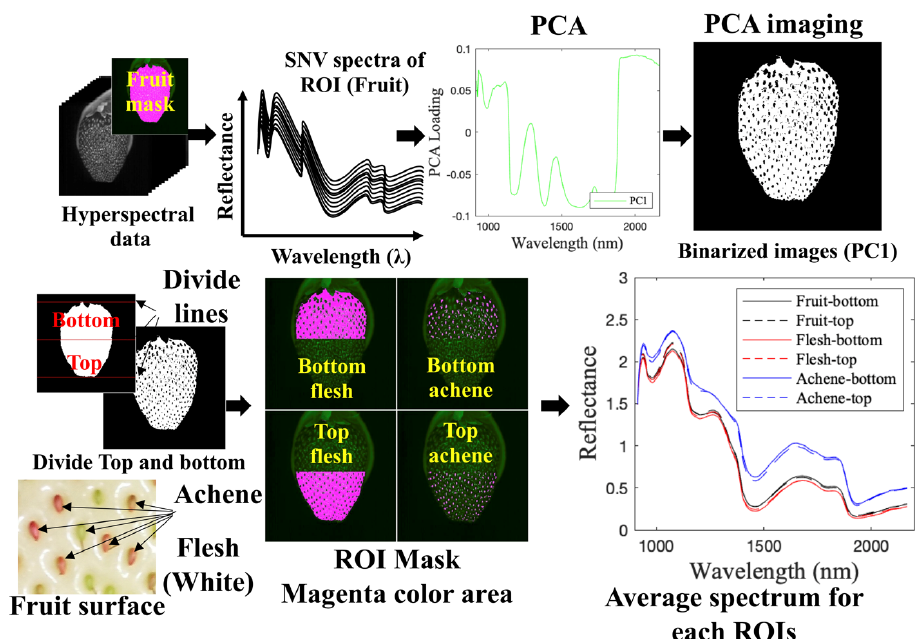
Figure 3. Preprocessing procedures for hyperspectral data, extraction of ROIs by PCA imaging and image processing, average spectra extracted from 6 ROIs (Fruit-bottom, Fruit-top, Flesh-bottom, Flesh-top, Achene-bottom and Achene-top).